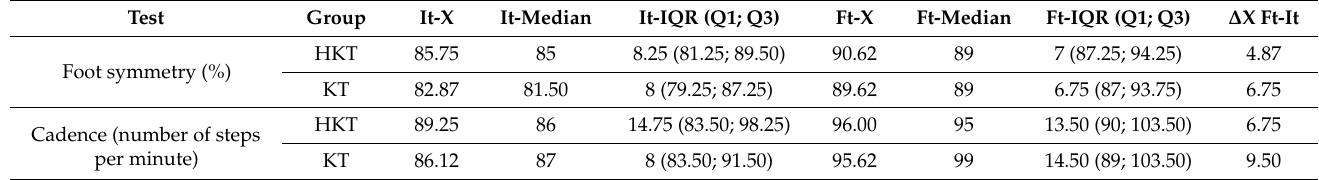
Table 4. Statistical analysis of PodoSmart test